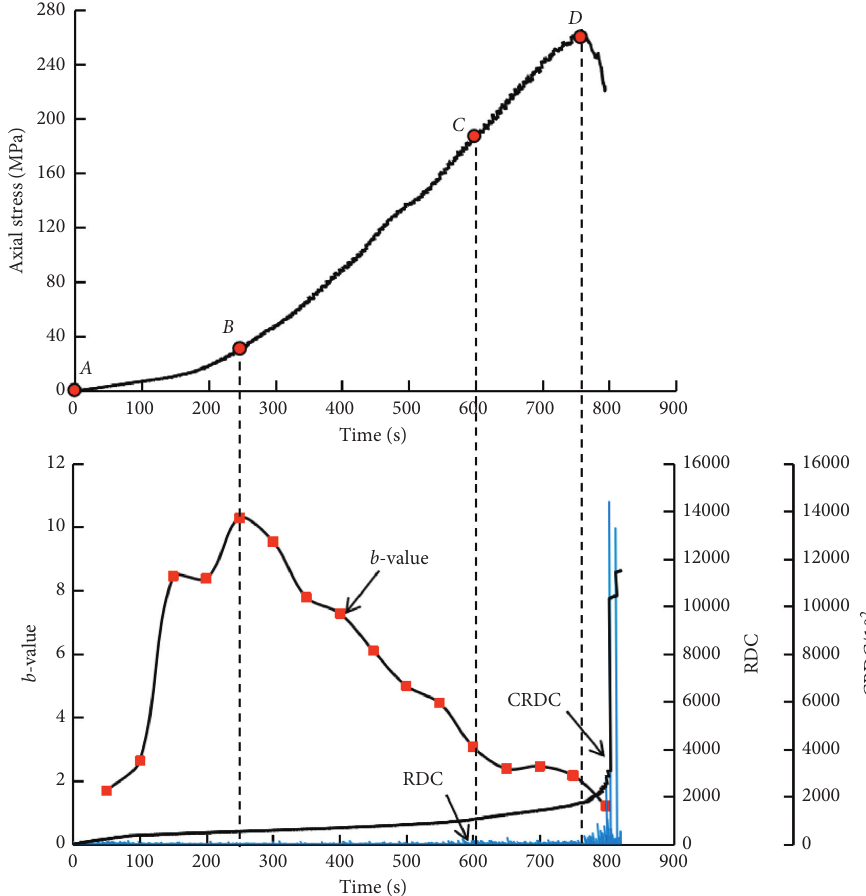
Figure 4: The evolutions of stress, b -value, RDC, and CRDC of AE with time for the intact